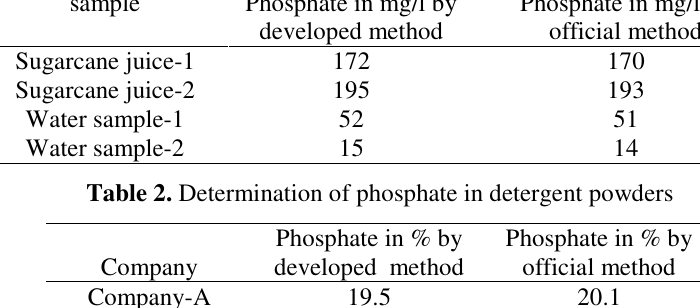
Table 1. Determination of phosphate in sugar cane juices. sample